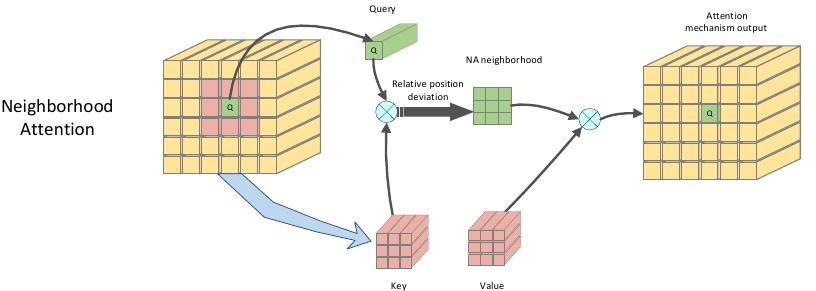
Figure 3. Q, K, and V structure of neighborhood attention. Given a d ‐ dimensional source input matrix X, the attention score z element is defined by choosing the click model, as shown in Equation (5).